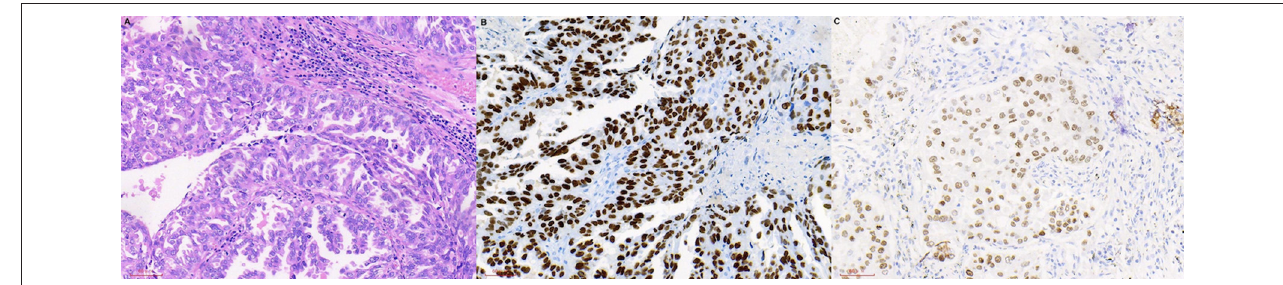
FIGURE 1 | HE and IHC staining of lung cancer tissues. (A) HE staining. (B) TTF-1 (IHC staining). (C) CK-7 (IHC staining). HE, hematoxylin-eosin; IHC, immunohistochemistry; TTF, transcription factor; CK, creatine